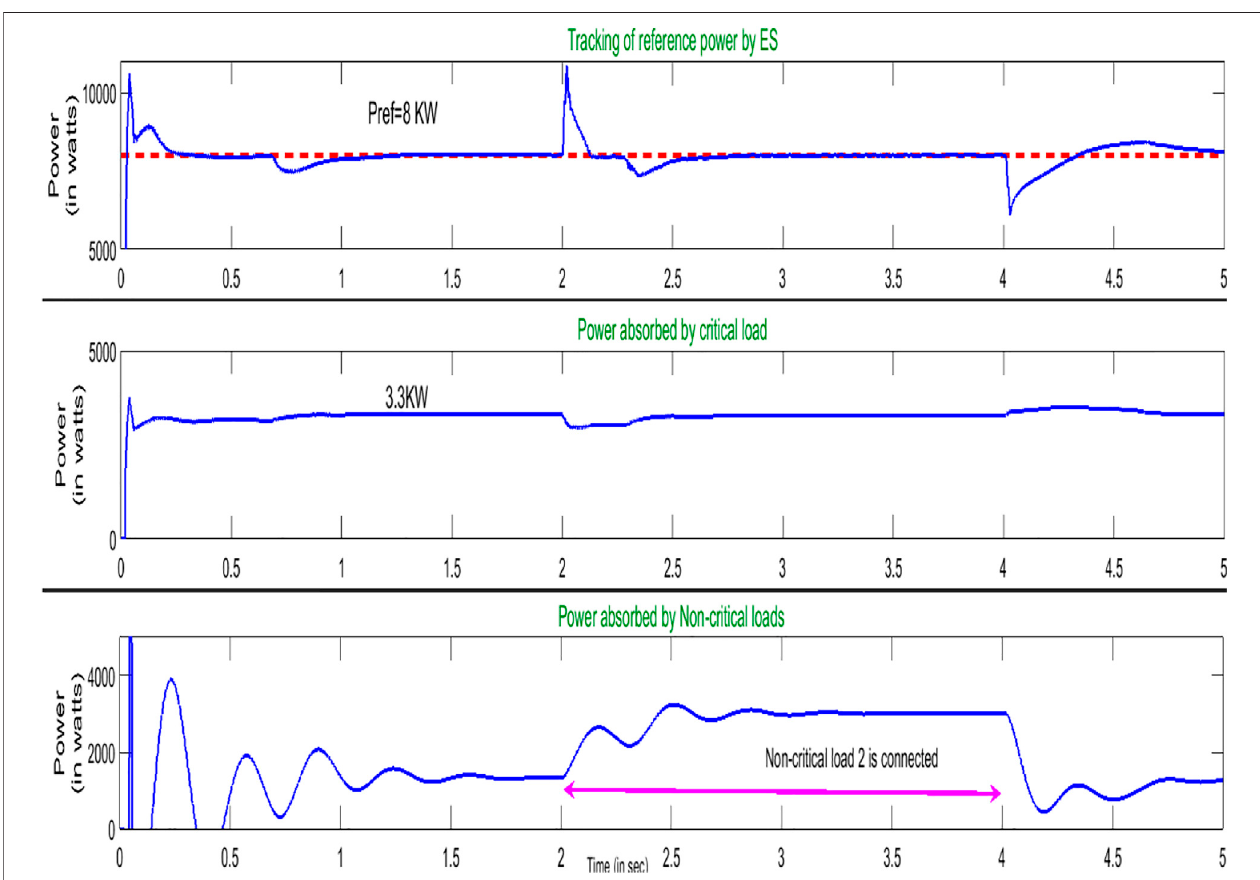
FIGURE 12 | Power across various elements for change in Non-critical